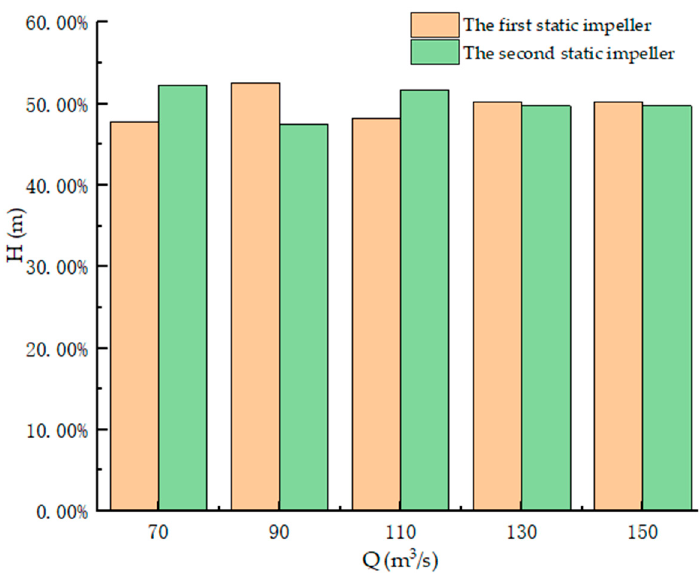
Figure 21. The proportion of each static impeller’s energy losses at different flow rate.